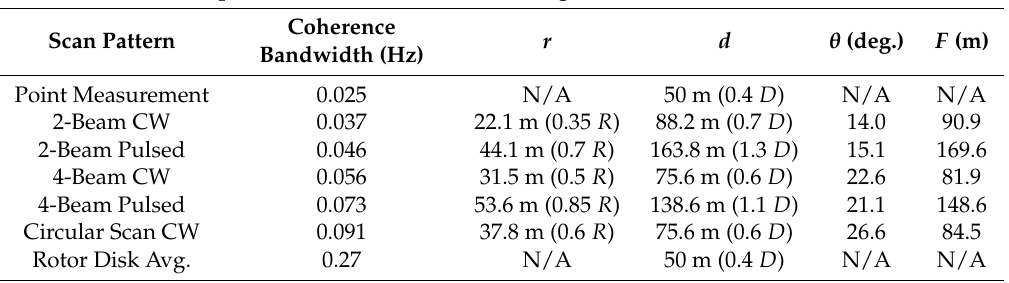
Table 1. Optimal coherence bandwidth, rotor effective wind speed measurement mean square error (MSE) (normalized by rotor effective wind speed variance), and linearized generator speed MSE (normalized by generator speed MSE with baseline feedback control) along with optimal scan parameters for each scan pattern. Optimal scan radii and preview distances are expressed in meters and as fractions of the rotor radius and preview distance,